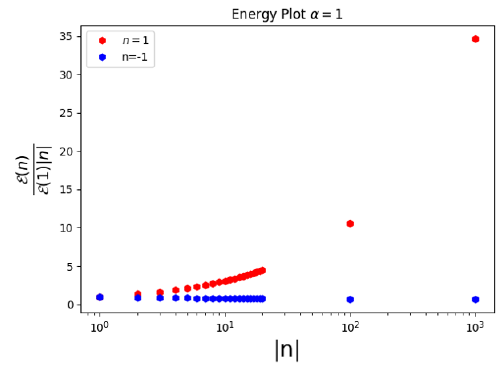
Figure 9 . Positive (cid:13)ux vortices have higher energy than their negative (cid:13)ux counterparts.